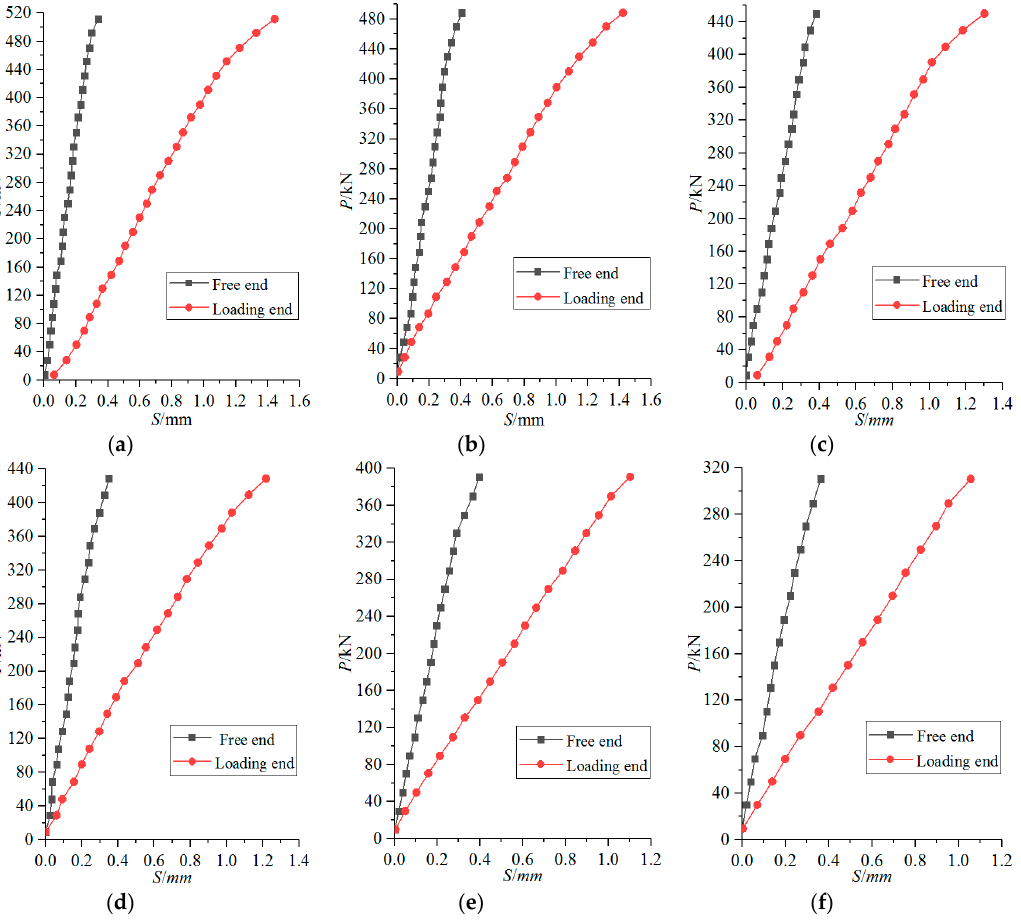
Figure 8. Actual loading end and free end P-S curves of specimens. ( a ) SRC-1; ( b ) SRC-2; ( c ) SRC-3; ( d ) SRC-4; ( e ) SRC-5; ( f ) SRC-6.